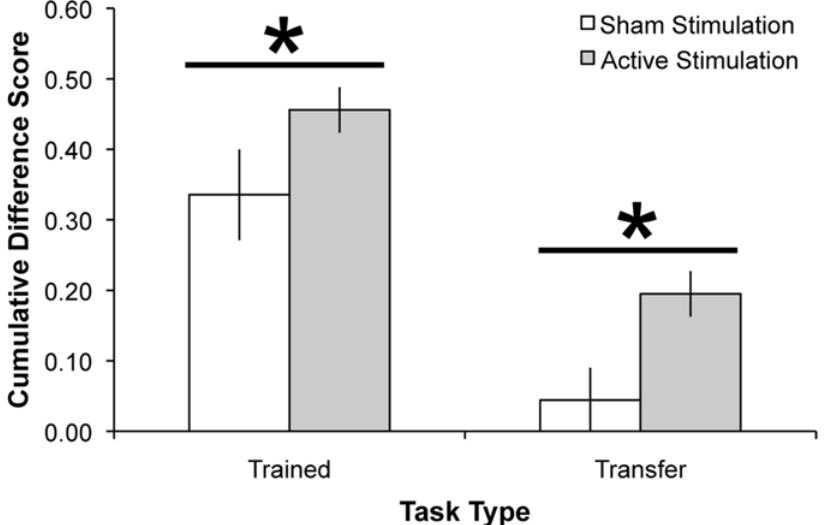
Fig 4. Performance gains per task. A: Stacked difference scores (follow-up compared to session 1) for the five trained tasks for the sham group and the average for the active stimulation groups. B: Stacked difference scores (follow-up compared to session 1) for the three transfer tasks for the sham group and the average for the active stimulation groups. Error bars represent standard error of the mean.